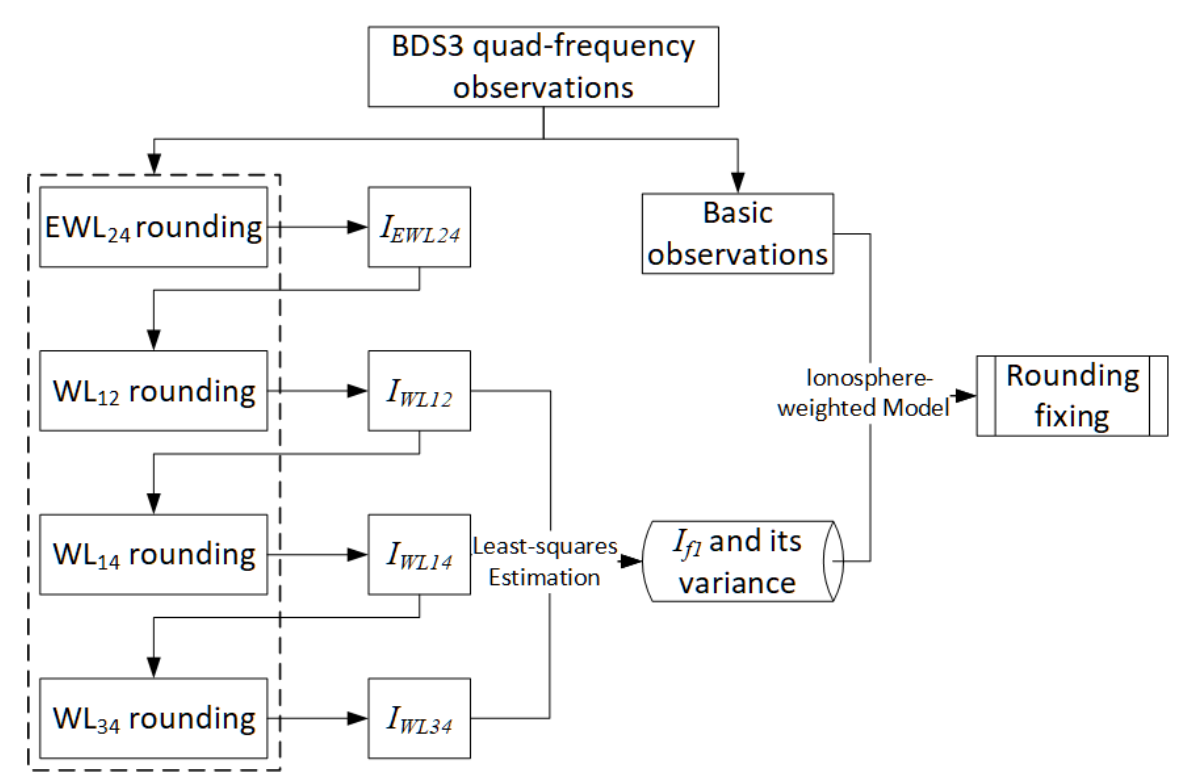
Figure 1. Algorithm process of the quad-frequency ionosphere-weighted model. Utilizing the above model, when the ambiguity accuracy and deviation are obtained, the a priori success rate of ambiguity rounding fixing can be calculated according to Equation (9). In this study, we assumed that the residual tropospheric delays and multipath delays were systematic error δ and the observation noise was random error σ . At the same time, assuming that the observation accuracy of DD phase is σ φ = 3 mm and σ φ = 5 mm, the ambiguity rounding success rates of the DFIF and QFIW models under different system errors are calculated by Equation